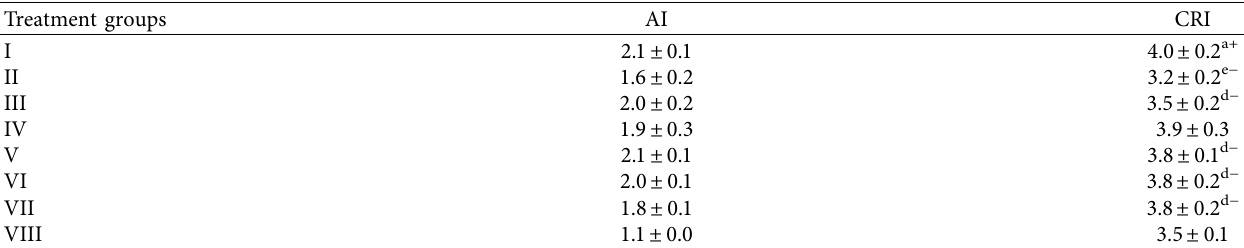
Table 11: Effect of 50–400mg/kg/day of CVE on the atherogenic index (AI) and the coronary artery index (CRI) in DOX-intoxicated rats. Treatment